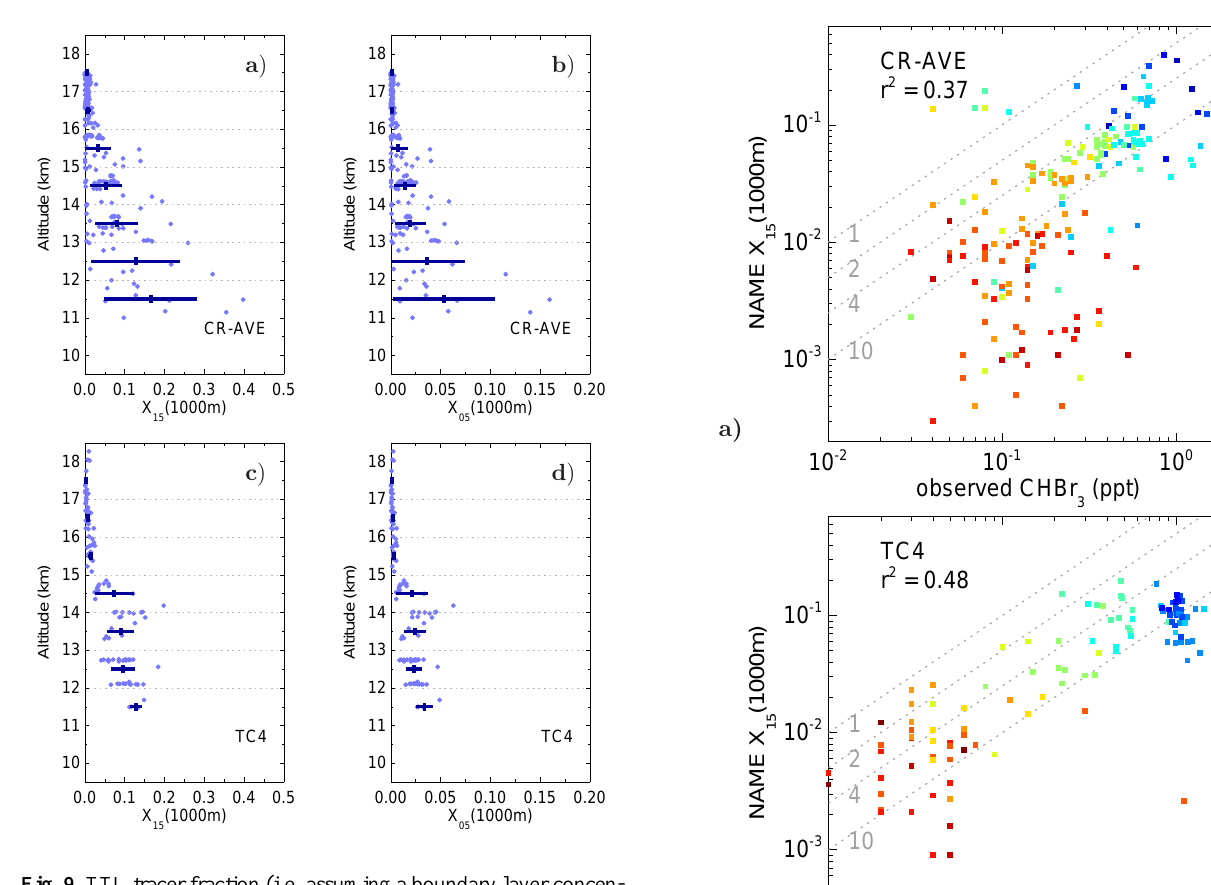
Fig. 9. TTL tracer fraction (i.e. assuming a boundary layer concentration of 1) calculated from NAME back trajectories corresponding to the measurements presented in figure 8 for CR-AVE (a and b) and TC4 (c and d). The tracer is initialised at 1 km agl. In a and c (b and d) the tracer has an e-folding lifetime of 15 (5) days. The solid black lines show the mean ± 1 standard deviation in each 1 km altitude bin. Note that the horizontal scales are not all the same. Fig. 10. The correlation between observed CHBr 3 and modelled T15 during CR-AVE (plot a, data from figure 8b and figure 9a) and TC4 (plot b, data from figure 8e and figure 9c). The dots are coloured by altitude—see the legend at the bottom of plot b. The grey lines indicate where there is a linear relationship between observation and model, and the scaling factor required to match model to observation is noted at the left end of each line. Note that CHBr 3 was not detected in 47 (2) out of 230 (112) samples collected during CR-AVE (TC4); these data are not presented in plot a (b), though they are included in the correlation coefficient calculations.